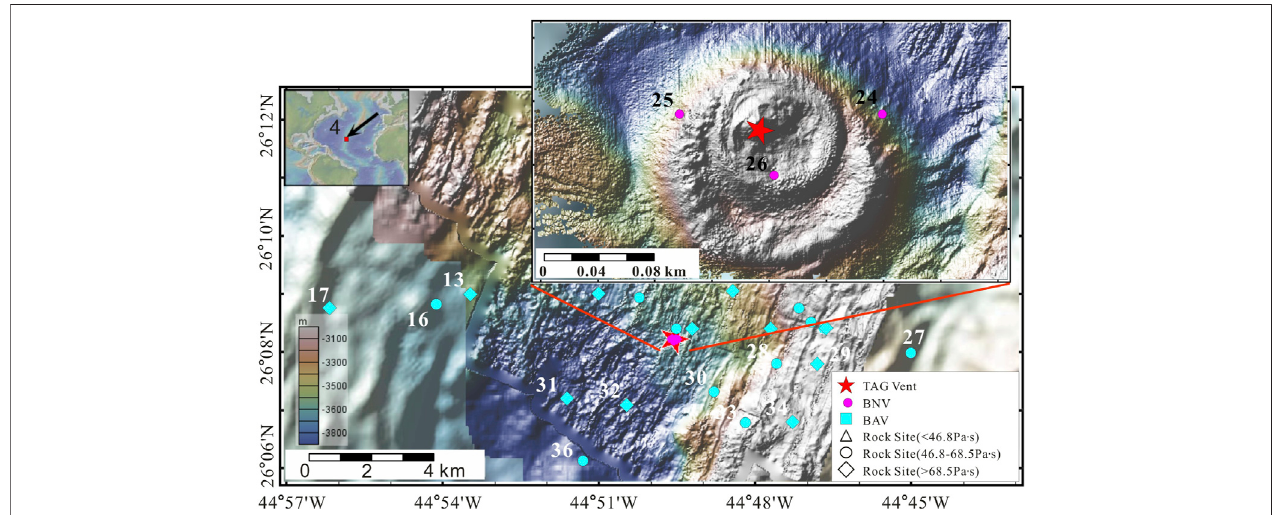
FIGURE 3 | Bathymetric map from GeoMapApp, showing the locations of the TAG vent and the sample sites. The inset (upper left) shows the MAR location of the TW vent. Thecolor bar ontheleft indicates thedepthsofthecontours (where red representsshallow and blue represents deep).The redstarindicates thehydrothermal vent. ThepinkcircleandcyantrianglesdenotetheBNVandBAVsites,respectively.Atthesitesmarkedbyopentriangles,circles,andrhombuses, thebasaltviscosityis < 46.8, 46.8 – 68.7, and > 68.7 Pa · s, respectively. The vicinities of the vents are delineated by the red boxes.